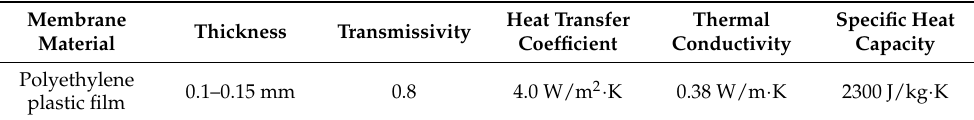
Table 3. Membrane